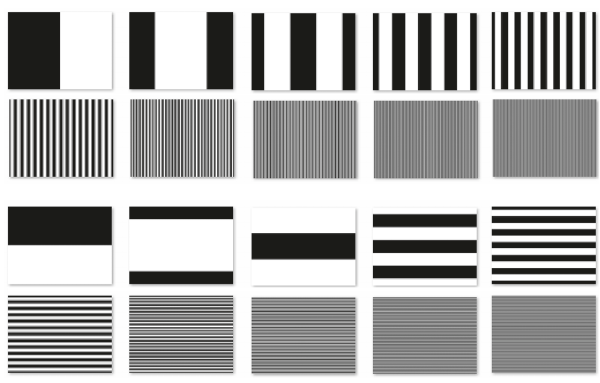
Figure 3: An illustration of the structured light system calibration. The captured image was selected in a set of the calibrated images, which are the projector project the patterns on the checkerboard and captured by the camera. The projected image is estimated with subpixel precision using local homographies to each corner in the captured images [1].